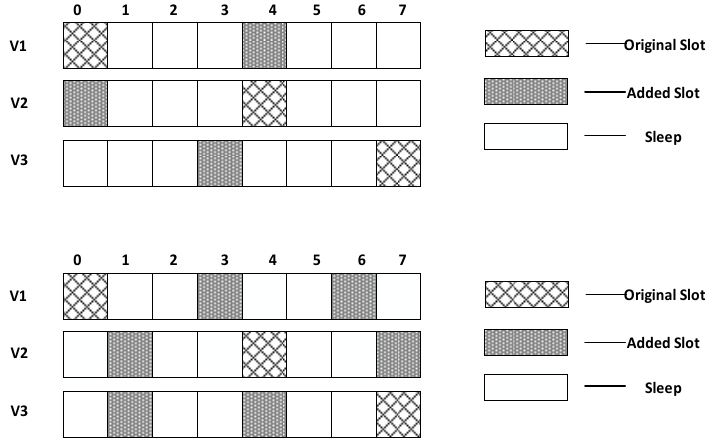
Figure 5. The added slots in the third layer ( top ) and the added slots in the fourth layer ( below ).